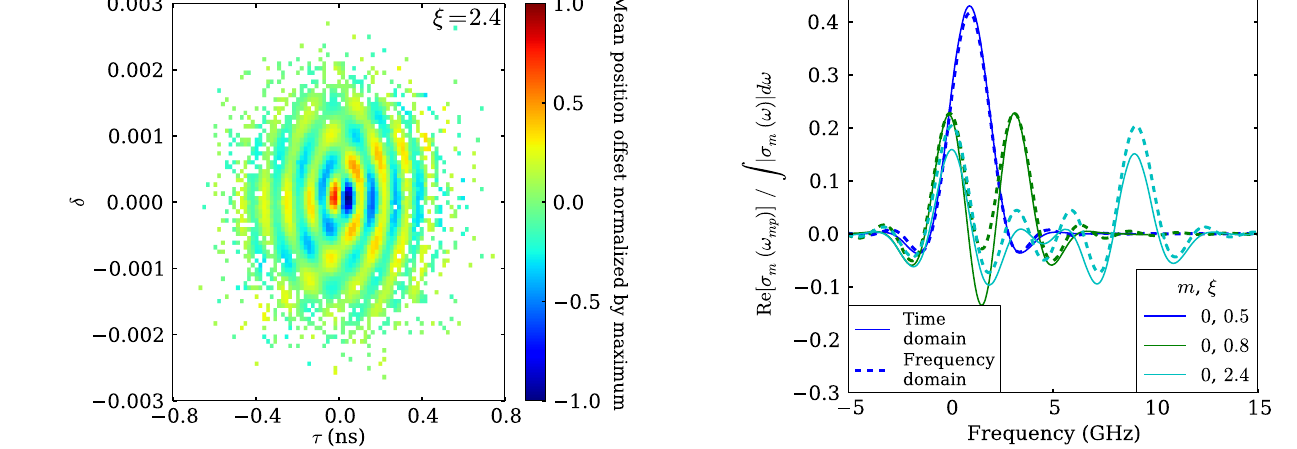
radial and azimuthal geometry of the mode is fixed and only the phase offset due to the chromaticity changes.